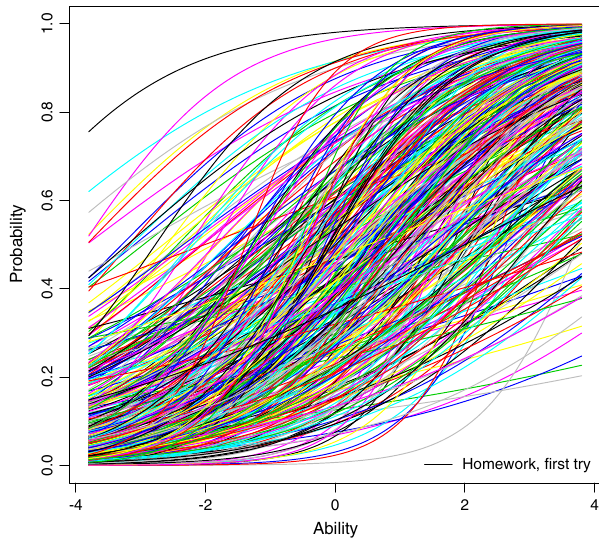
FIG. 4. Item characteristic curves for homework.